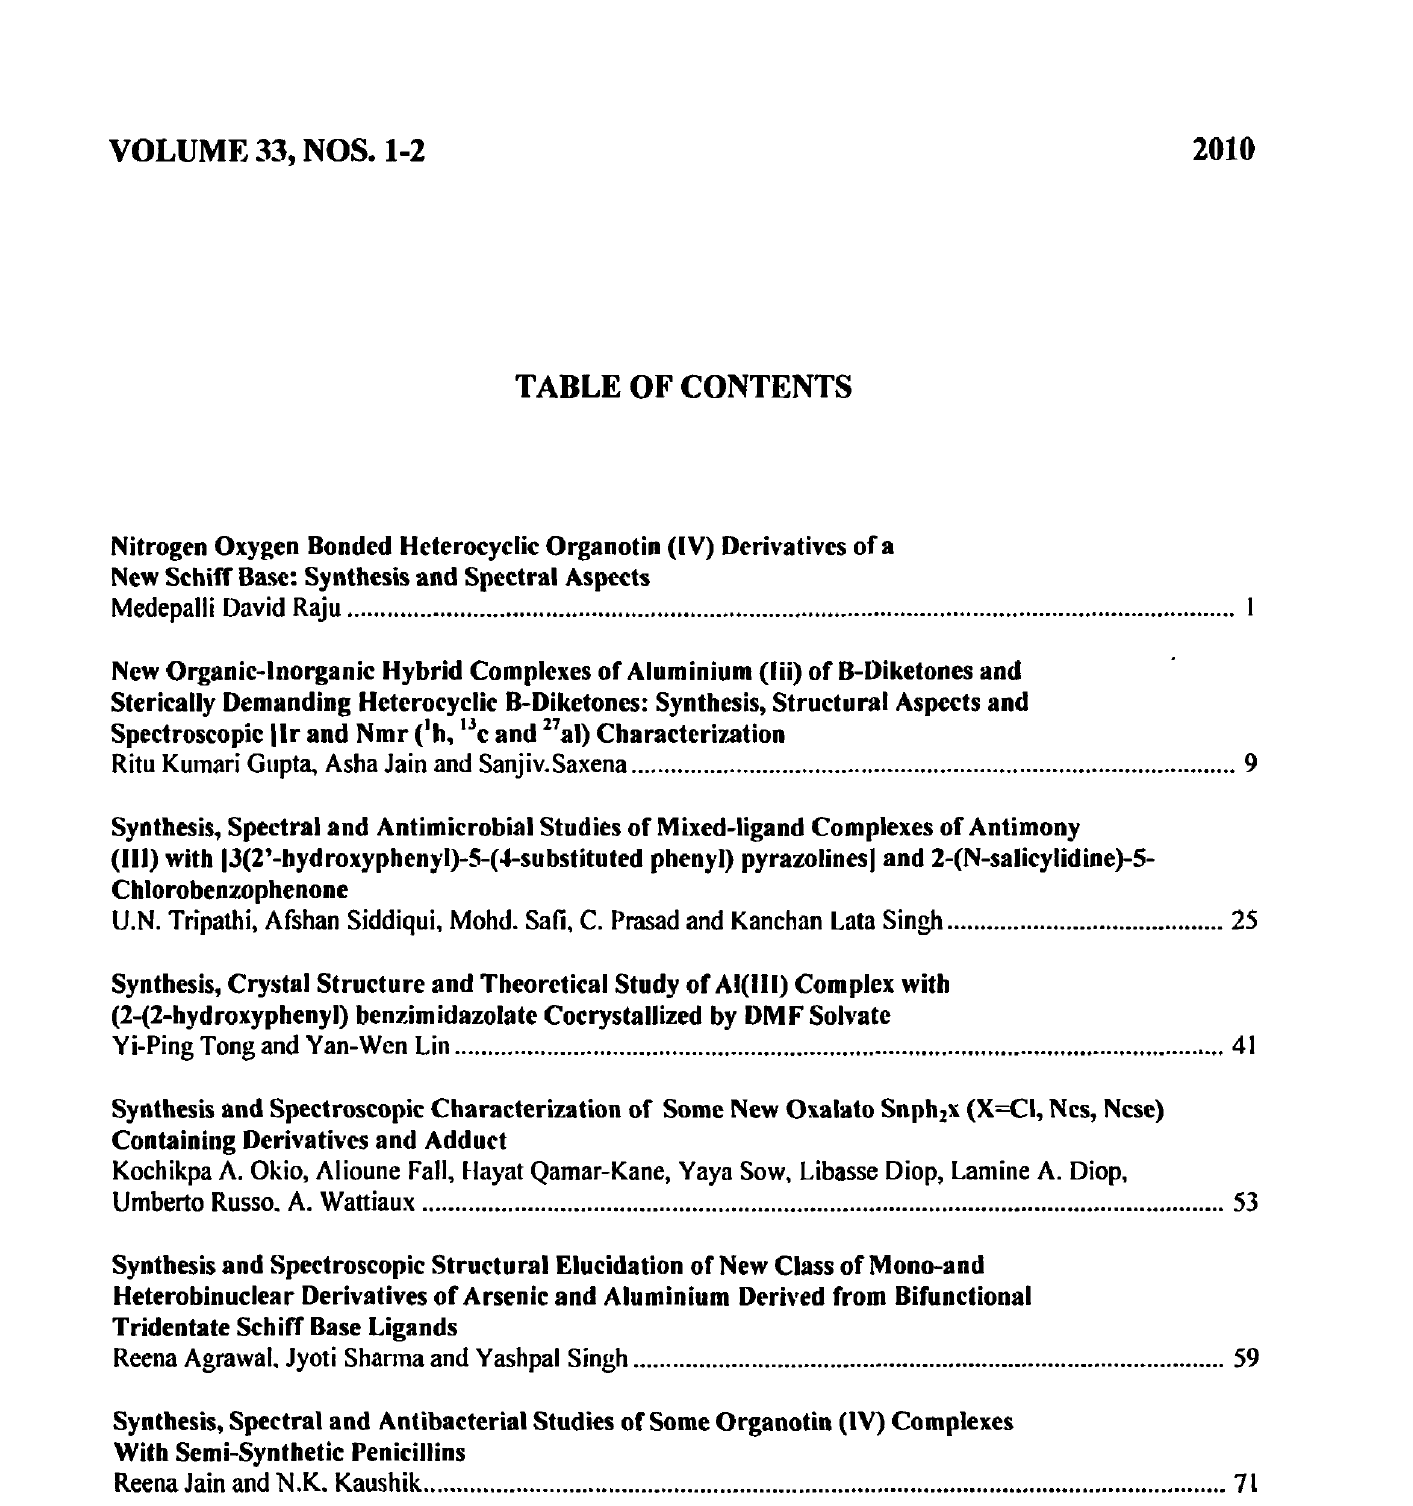
Synthesis, Crystal Structure and Theoretical Study of AI(III) Complex with (2-(2-hydroxyphenyl) benzimidazolatc Cocrystallized by DMFSolvate